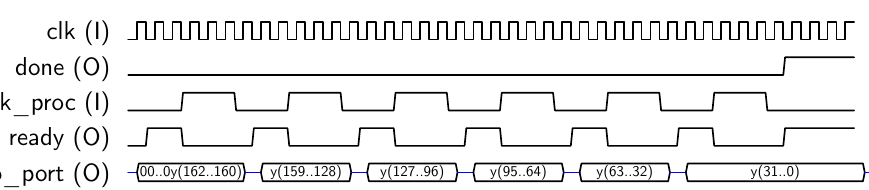
Figure 11. Sequence for SP ECC x coordinate retrieval.